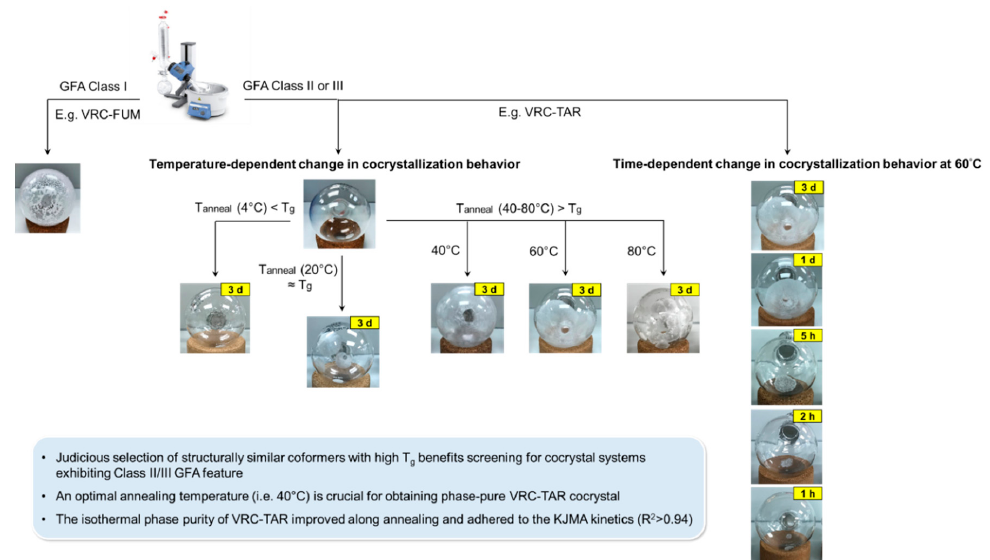
Figure 8. Schematic of VRC-FUM and VRC-TAR cocrystals formation via rotary evaporation.